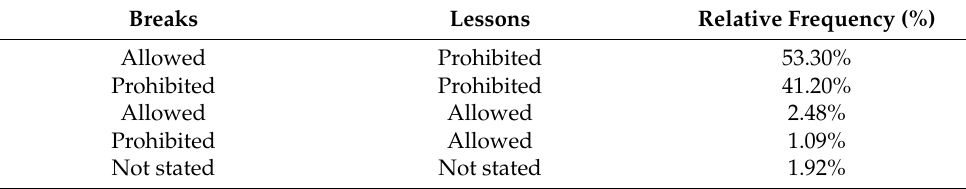
Table 2. Using mobile phones in school (from the children’s